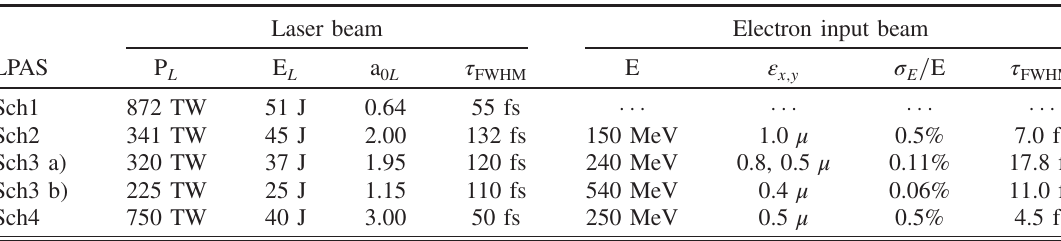
TABLE III. Laser and electron input beam parameters of the LWFA LPAS. The plasma density is n p ¼ 1 . 10 17 cm − 3 for all the LPAS cases. The same notations as for Table